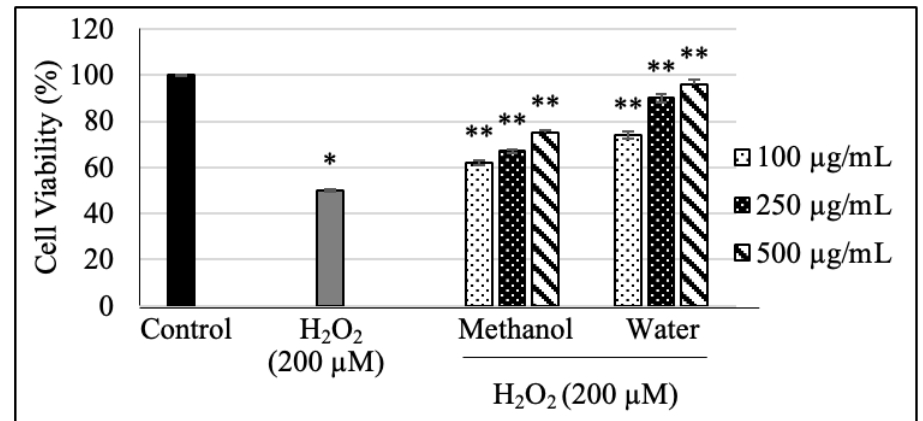
FIGURE 1 - Neuroprotective effects of G. corniculatum extracts on the viability of dPC12 cells against H Control: untreated dPC12 cells. * p < 0.05 vs.control group. ** p < 0.05 vs. H